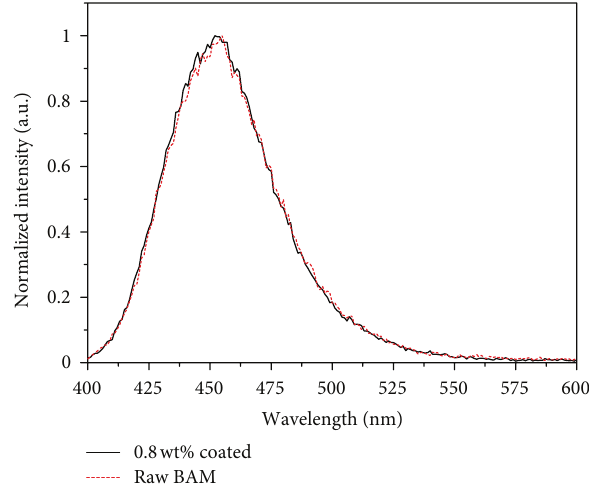
Figure 4: Emission spectra of 0.4 wt% CaF 2 -coated BAM and raw BAM.